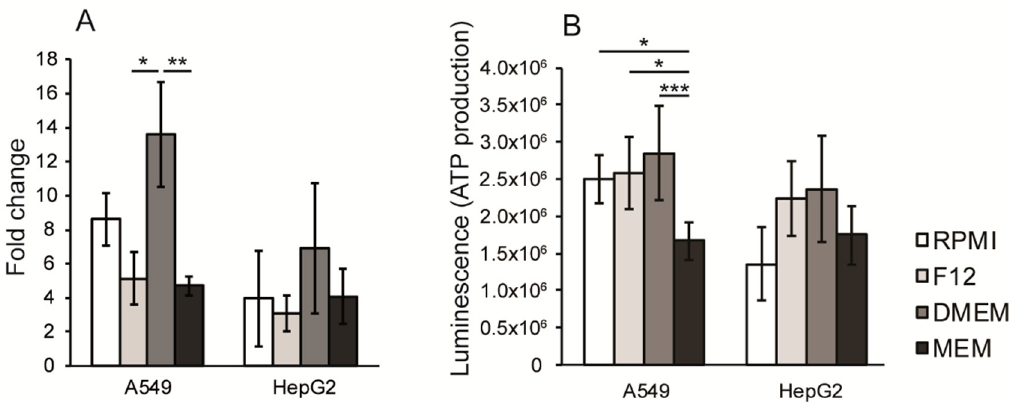
Figure 2. The effect on cell growth, ATP production and morphology by cell culture in different media ( A ) Cell growth after four days, shown as fold change, measured by trypan blue exclusion assay. ( B ) Base line production of ATP of cells cultured in the different media, measured at 72 h after seeding. Data is presented as mean +/ − standard deviation. Statistical analysis was performed by using the Kruskall–Wallis test (* p < 0.05; ** p < 0.01; *** p < 0.001).